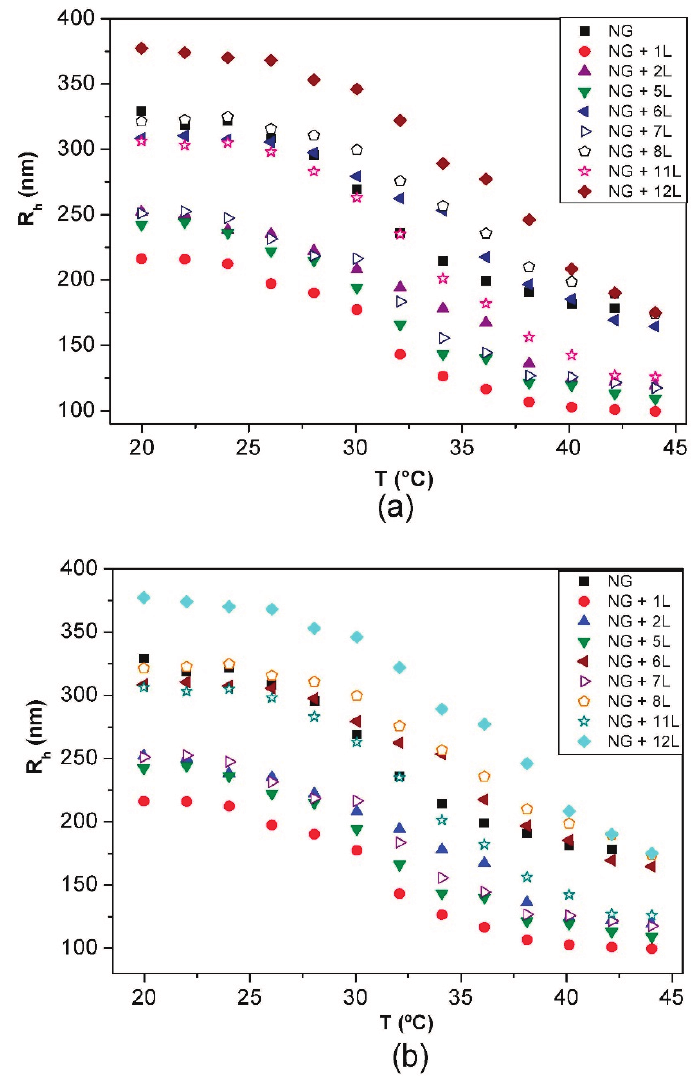
Figure 8. Hydrodynamic radius R h vs. temperature for PNIPAM- co -MAA with different layers of: ( a ) PLL/PGA and ( b ) CHIT/DEXS. For clarity, only the heating cycles are shown. Reproduced with permission from [8], copyright 2010,